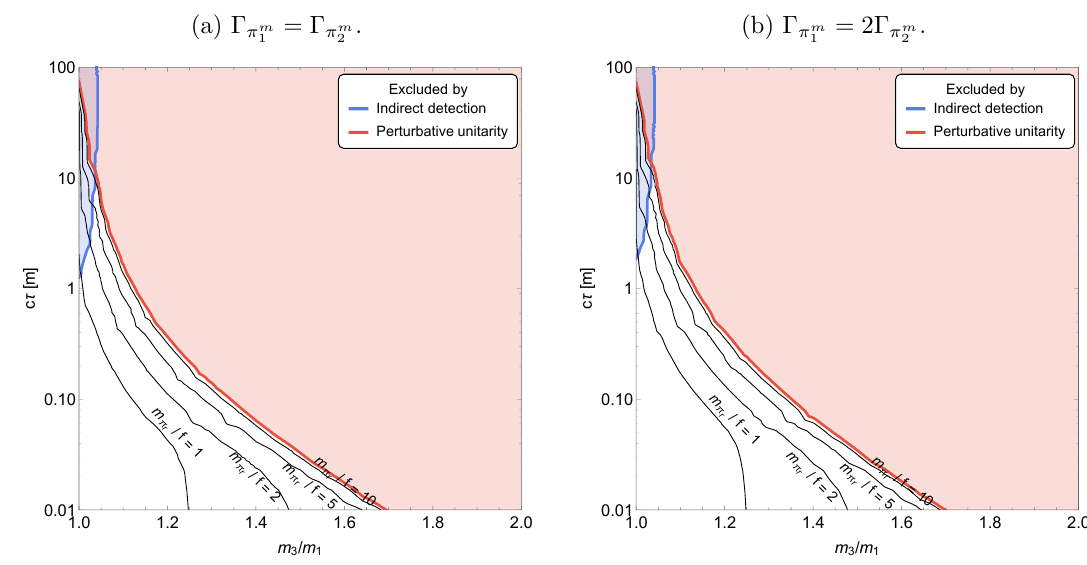
Figure 8. Allowed region of parameter space for the benchmark CIIe for di(cid:11)erent ratios of the decay widths. The mass of triplet of the preserved SU(2) is kept at a constant value of 75 GeV. The black contour lines represent constant values of m (cid:25) =f . The blue region is excluded by indirect 3 detection DM searches, while the red one by perturbative unitarity constraints. The decay length is that of the lightest unstable